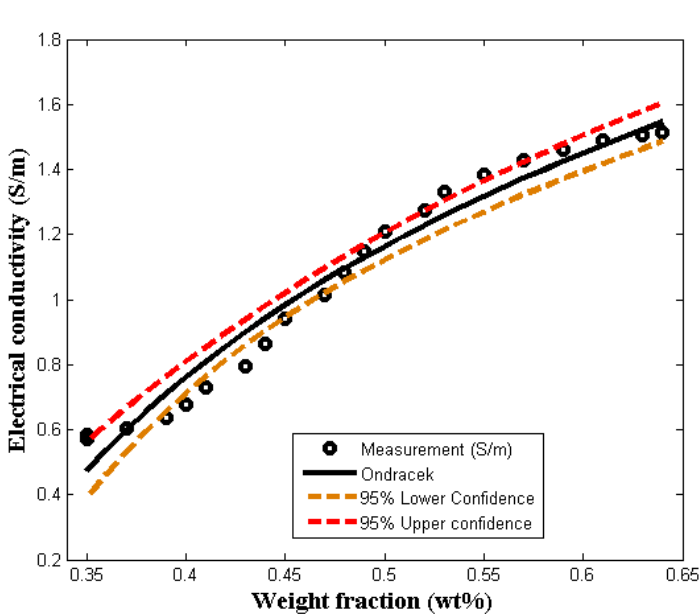
Figure 3. Comparing the linearized Ondracek model (LOM) with experimental measurement. Table 1. Linearized Ondracek model performance